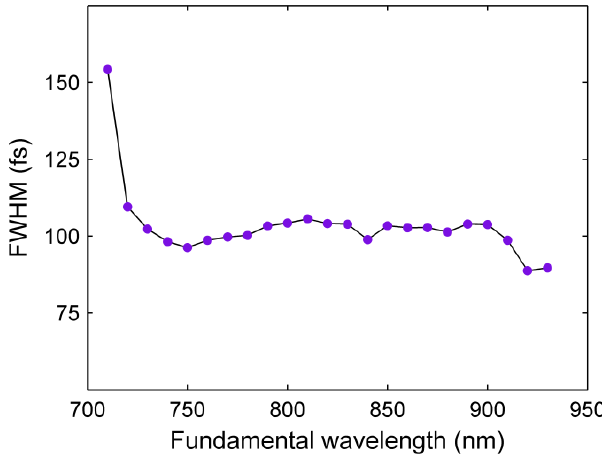
Figure 10. Pulse duration of Tsunami oscillator measured with NPC SBO throughout the tuning range at fixed angular position of the crystal.